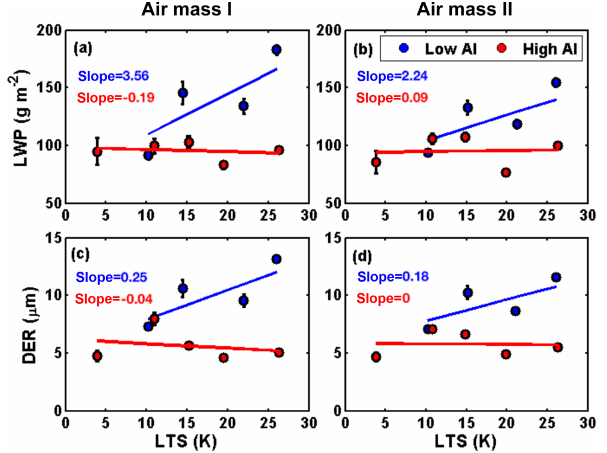
Figure 8. Cloud optical depth (COD) and cloud droplet effective radius (DER) as a function of liquid water path (LWP) at low (in blue) and high (in red) scattering aerosol index (AI) levels under cluster I air-mass ( a , c ) and cluster II air-mass ( b , d ) conditions. Low and high scattering AIs are defined as the lowest and highest quarter of all scattering AI samples,